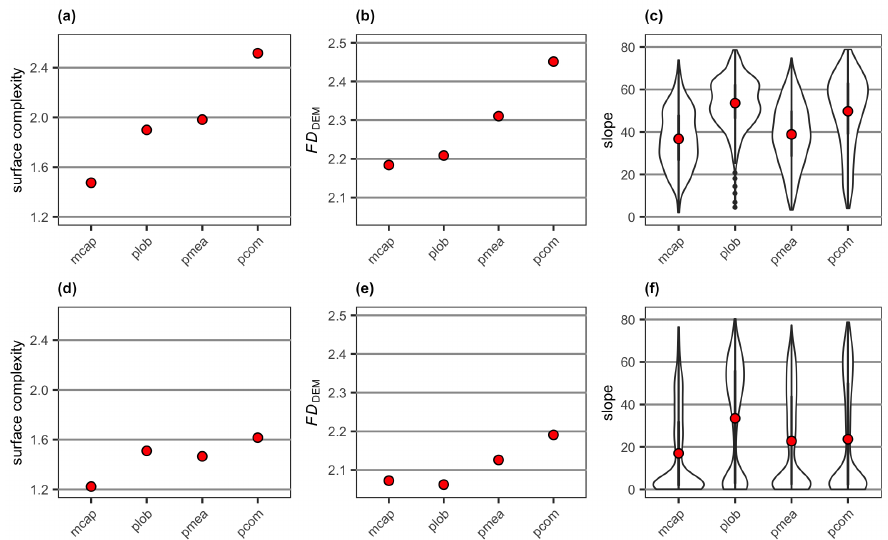
Figure 11. Values of ( a ) surface complexity and ( b ) FD DEM and a violin plot for ( c ) slope extracted from the DEMs of the four reconstructed coral colonies with different morphologies, and values of ( d ) surface complexity and ( e ) FD DEM and a violin plot for ( f ) slope extracted from DEMs of the four reconstructed coral colonies with different morphologies with a substratum: mcap = encrusting M. capitata , plob = mounding P. lobata , pmea = branching P. meandrina and pcom = branching P. compressa . Note surface complexity and FD DEM generate a single value per DEM, while slope is generated for each cell of a DEM. The mean value of slope for each colony is shown as red points.